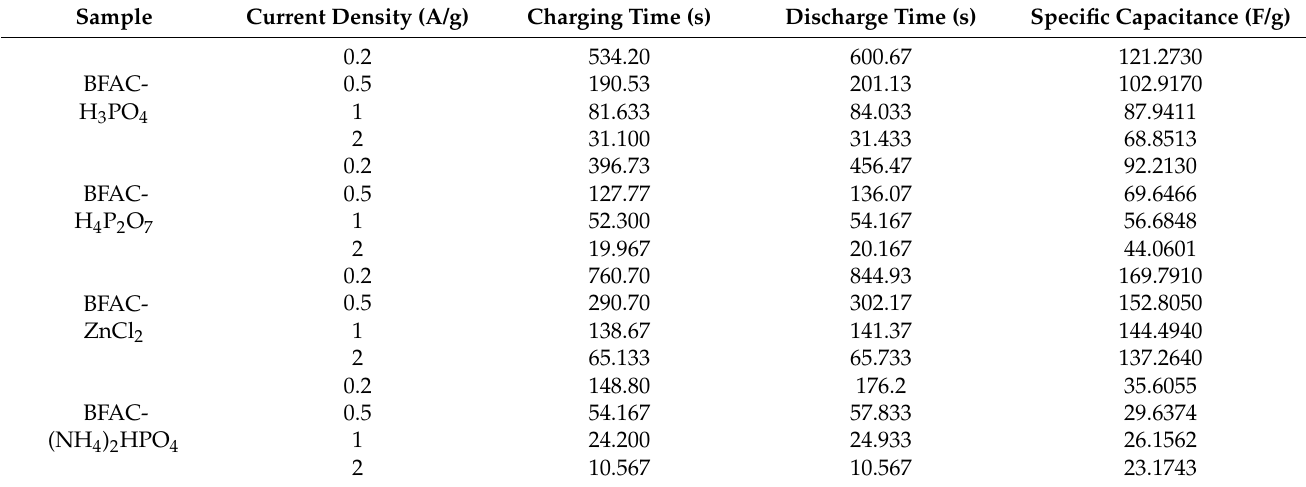
Figure 10. Charge/discharge curves of BFACs at various current densities ( a ) BFAC-H 3 PO 4 , ( b ) BFAC- Table 3. Charge and discharge time and specific capacitance of BFACs.